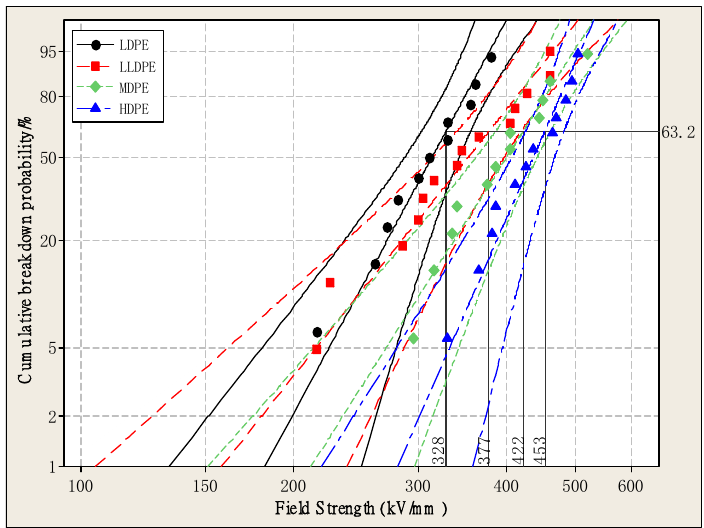
Figure 4. The Weibull plots of the direct current breakdown strength of four kinds of polyethylene.